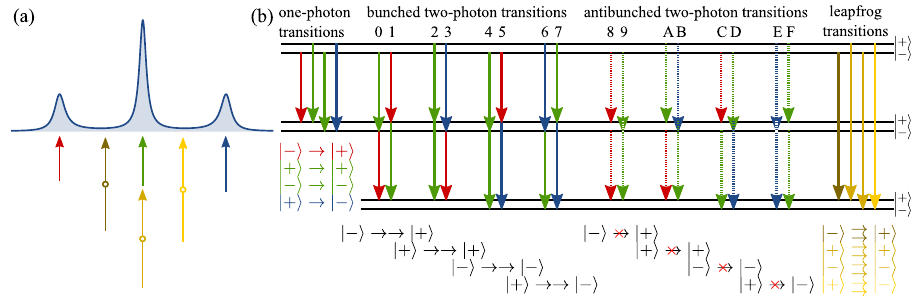
Figure 6. ( a ) Line shape and ( b ) level structure of the Mollow triplet. The lineshape is easily understood as the result of one-photon transitions between neighbour rungs of the dressed-state ladder, shown in red, green and blue. Since there are two degenerate green arrows, the central peak to which they correspond is twice as large. This picture is also helpful to visualise two-photon transitions. All the possible combinations are shown in (b). Combinations such as 8 and E, that occur only once, behave as expected. Other cases that occur multiple times, such as red and green transitions that happen in 0, 1, A and C, require exact computations to identify their actual behaviour. Also shown are the “leapfrog transitions”, that jump over the intermediate manifold in a direct two-photon emission. The cases where photons have the same frequency is shown in panel